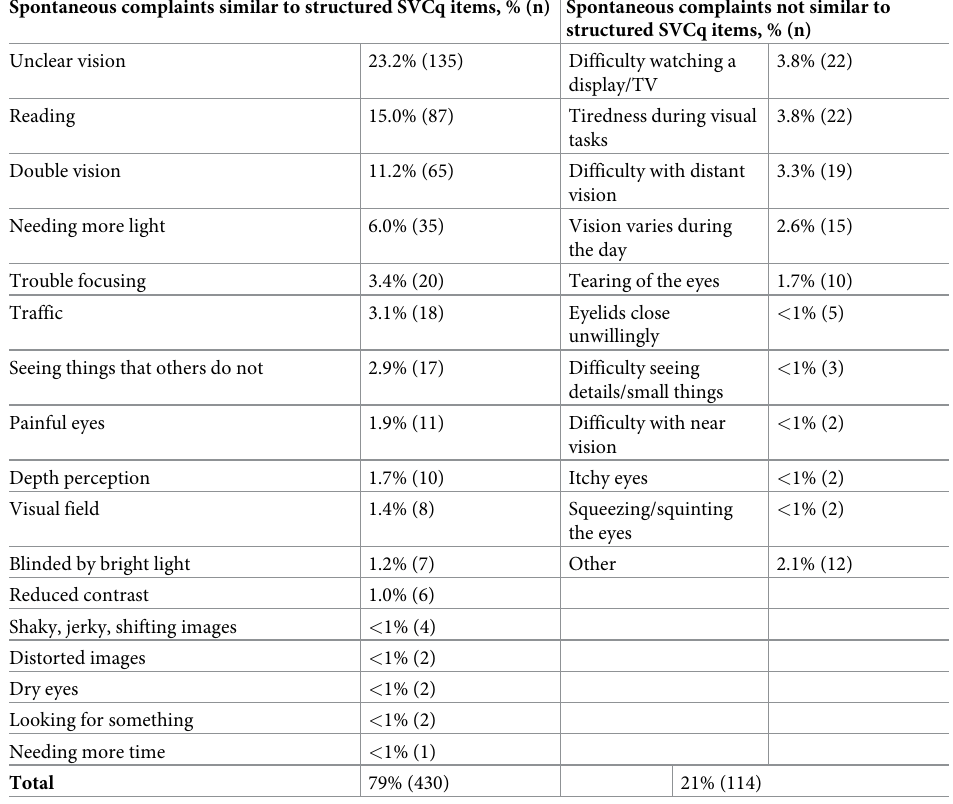
Table 3. Visual complaints reported spontaneously on the first, open-ended question of the SVCq by people with PD. Spontaneous complaints similar to structured SVCq items, % (n) Spontaneous complaints not similar to